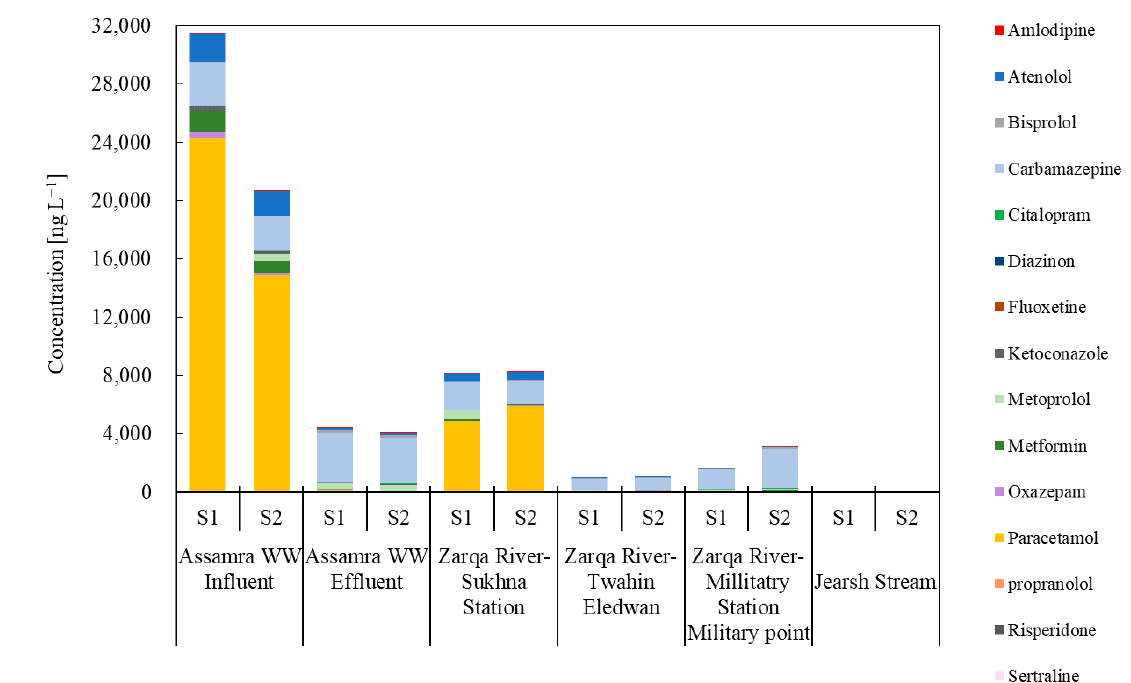
Figure 2. Concentrations (ng L − 1 ) of pharmaceutically active compounds (PhACs, excluding antibiotics) in Assamra wastewater treatment plant (WWTP) influent ( n = 2) and effluent ( n = 2), and in water from the Zarqa River at Sukhna station, ( n = 2), Twahin Eledwan station ( n = 2), Military station ( n = 2) and Jerash stream ( n = 2). S1, S2 = parallel samples.